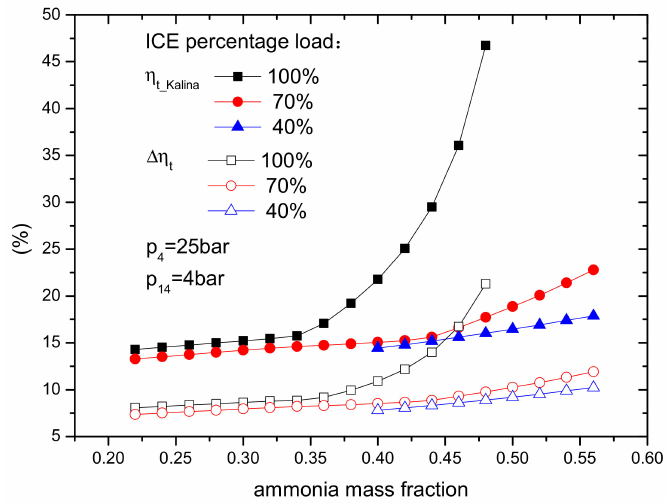
Figure 10. Effects of ammonia mass fraction on ∆ η t